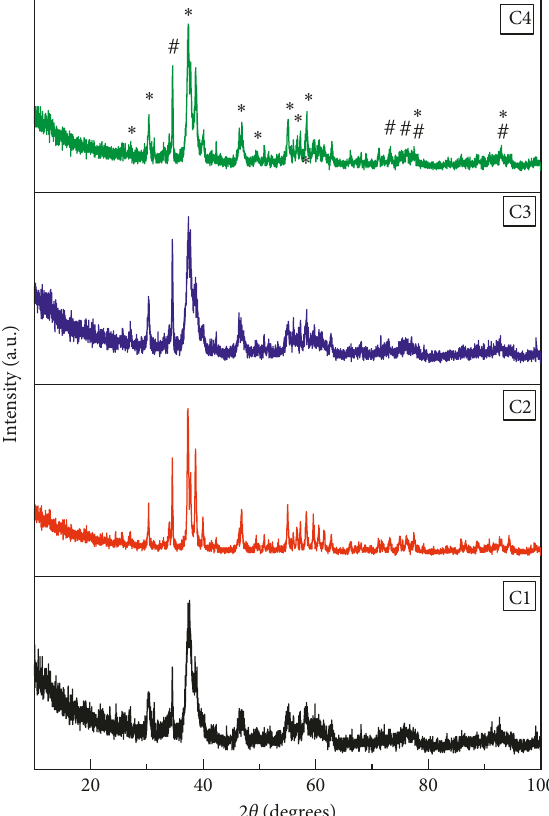
Figure 3: XRD diffractograms of the bone samples from the layers C1, C2, C3, and C4 analyzed, where peaks of hydroxyapatite ( ∗ ) (Ca 10 (OH) 2 (PO 4 ) 6 ) and calcite (#) (CaCO 3 ) are